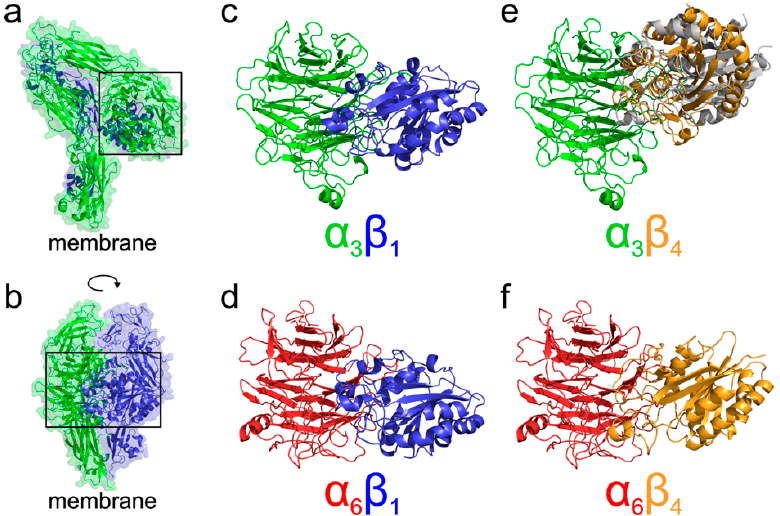
Figure 6. Docking of α / β integrin N-terminal domains. ( a , b ) An example of resting state structure of extracellular domains of the α 3 β 1 integrin as obtained from I-TASSER homology modelling. As expected from the crystal structures available for threading by I-TASSER the overall architecture of the resulting model is similar to α X β 2 (PDB ID 4neh; [12]) or α IIb β 3 (PDB ID 3fcs; [13]) heterodimer structures. The interacting region of N-terminal domains is highlighted by the black rectangle. Panel ( a ) shows the α 3 subunit on top of the β 1 domains, while panel ( b ) represents the same structure rotated by 90 degrees orienting both the N-terminal domains to the front of the image. ( c – f ) The predicted arrangement of heterodimers formed by N-terminal domains of integrins α 3 β 1 ( c ), α 6 β 1 ( d ), α 3 β 4 ( e ), and α 6 β 4 ( f ) from the flexible side chain docking of the domains by ClusPro. In the case of α 3 β 4 ( f ) two binding modes are shown. The predicted most stable dimer with the β 4 domain (orange) interacting through the NV residues homologous with the typical Arg/Lys finger of β domains is compared to an alternative, less stable binding mode, employing the RPEK sequence (grey). Both binding modes are similar and suggest that the α 3 β 4 complex adopts different domain orientation compared to the remaining α 3 β 1, α 6 β 1, and α 6 β 4 cases. The α 3 domains are shown in green, β 1 in blue, α 6 in red, and β 4 in orange.